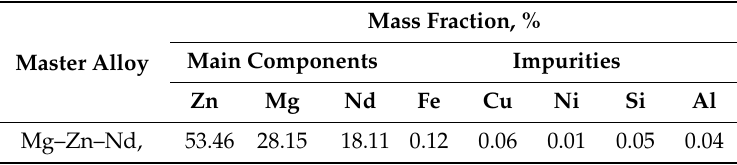
Table 1. Chemical composition of Mg–Zn–Nd master alloy. Master